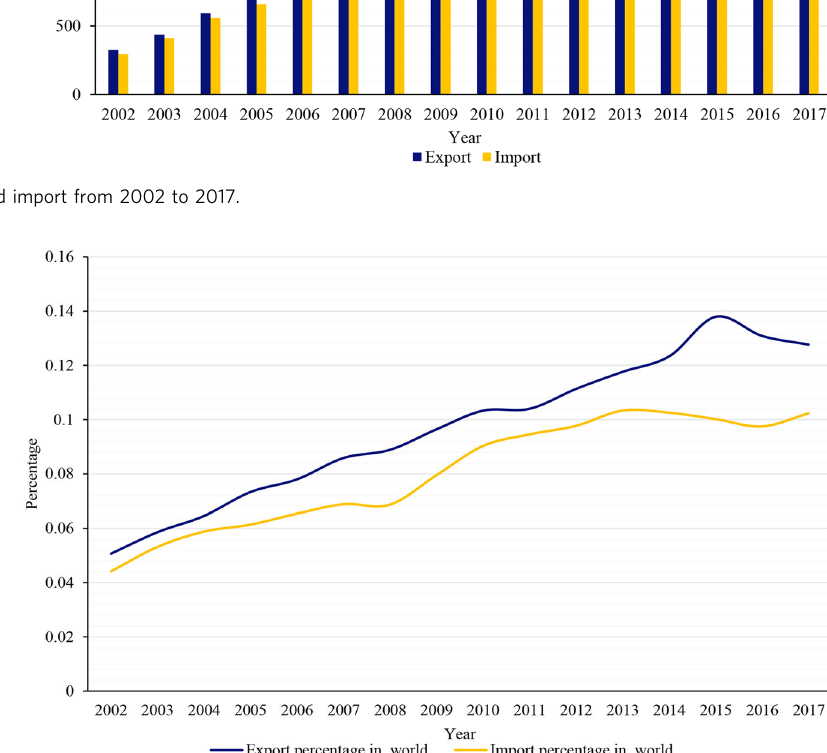
Fig. 5 China ’ s export and import percentage in world from 2002 to